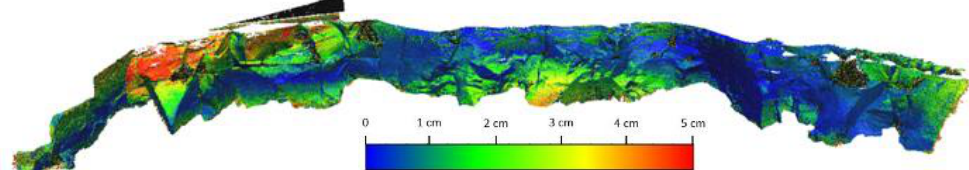
Figure 6. Error mapping of deviation between TSL and model P3-PS-Target-TFC.